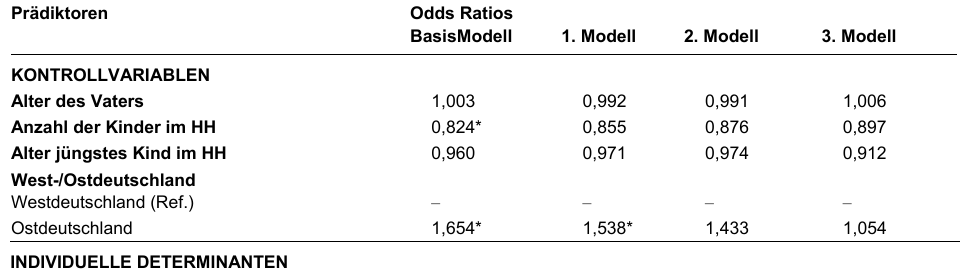
Tabelle 3 : Logistische Regression, Abhängige Variable: 0=wenig oder durchschnittlich aktive Väter; 1=aktive Väter Prädiktoren Odds Ratios BasisModell 1. Modell 2.